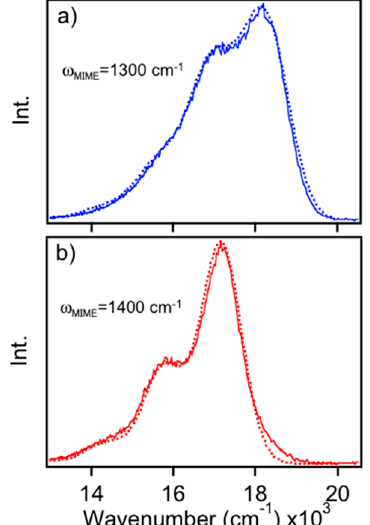
Figure 5. Representative single chain MEH-PPV PL spectra for: blue ( a ); and ( b ) red emitting forms. MIME progression intervals are included.